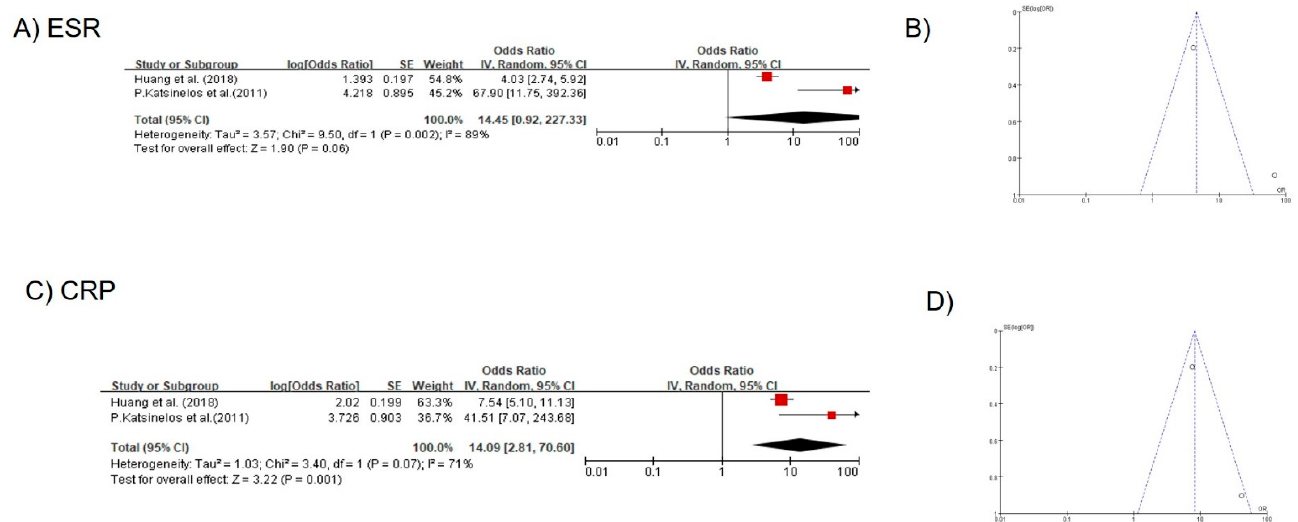
Figure 4. ( A ) forest plot of elevated ESR; ( B ) funnel plots of studies that examined elevated ESR; ( C ) forest plot of elevated CRP; ( D ) funnel plots of studies that examined elevated CRP.